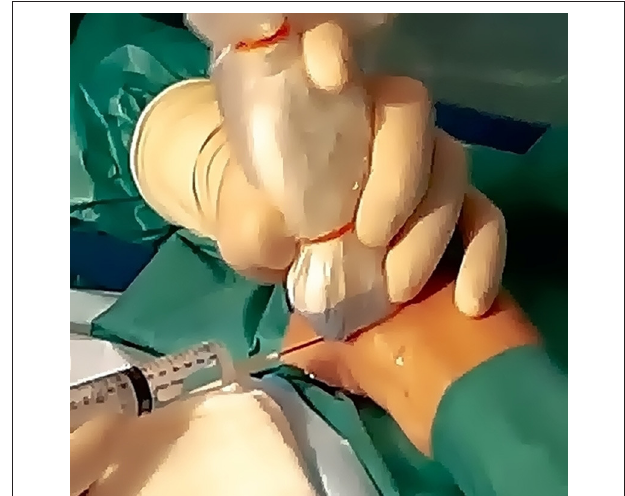
FIGURE 5 | Local anesthesia.